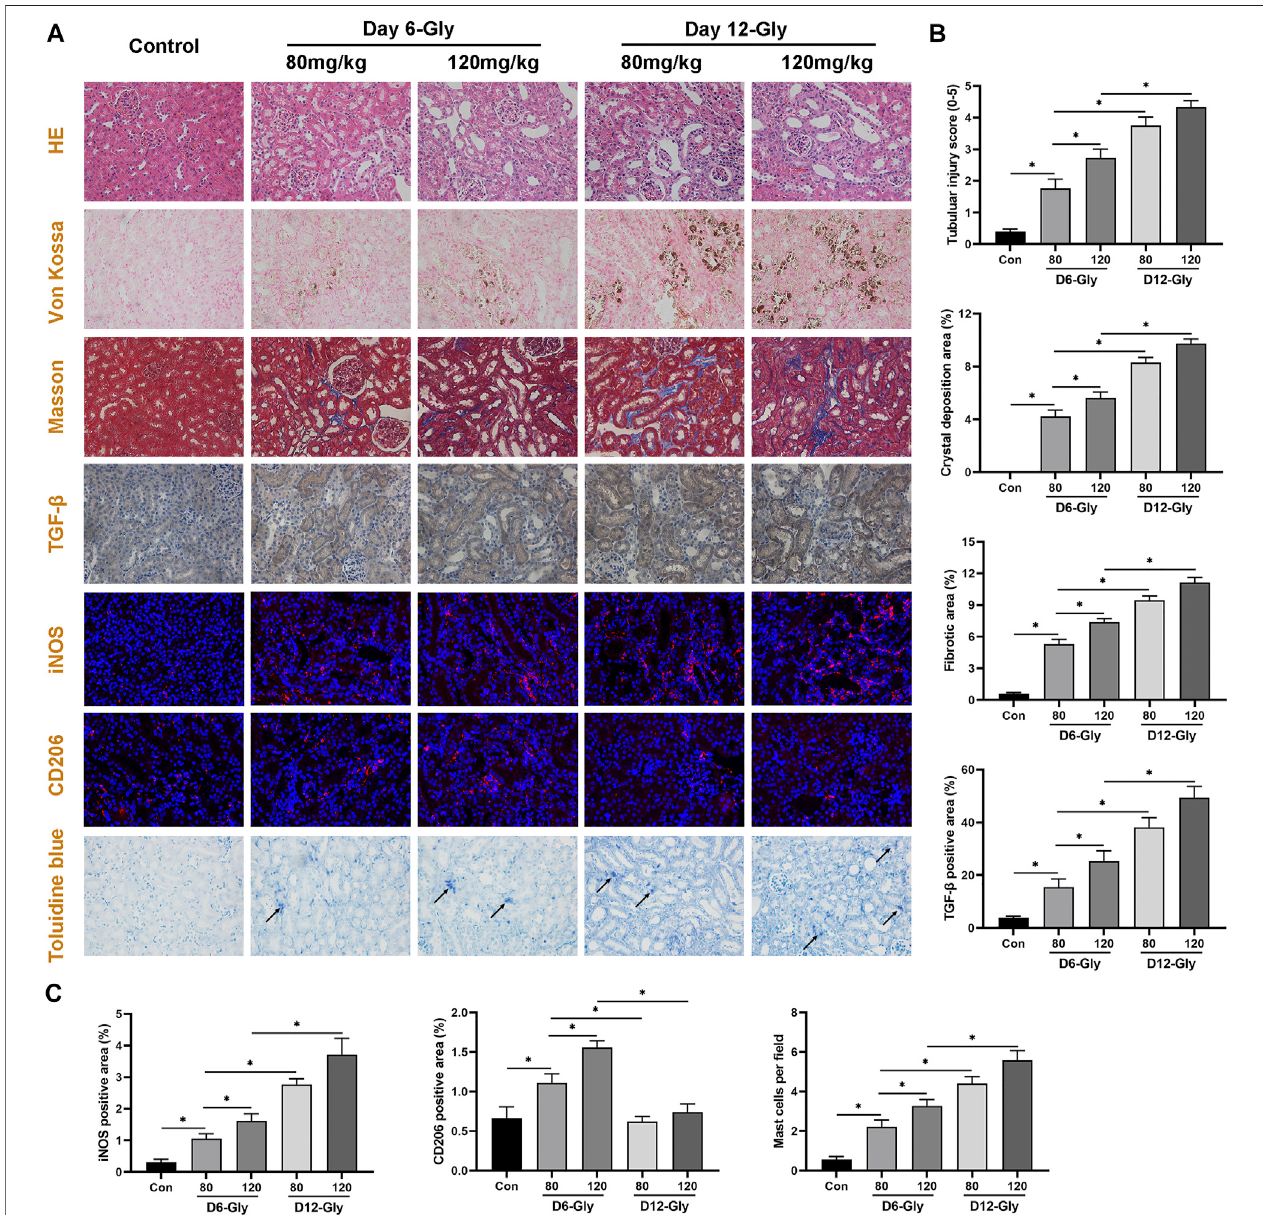
FIGURE 7 | Evaluation of kidney tubular injury, crystal deposition, fi brosis level, macrophage, and mast cell in fi ltration in a glyoxylate-induced hyperoxaluric mouse model. (A) Representative pictures of HE staining, Von Kossal staining, Masson staining, immunohistochemical staining, immuno fl uorescence staining, and Toluidine bluestaining(magni fi cation,400 × ). (B) Quanti fi cationofkidneytubularinjuryscore,CaOxcrystaldepositionarea,collagen fi berdepositionarea,andTGF- β positivearea. (C) Quanti fi cation of macrophage-related molecules in the iNOS (M1) and CD206 (M2) positive areas, and quanti fi cation of activated mast cell per fi eld. Gly, glyoxylate. The arrow indicates activated mast cells. * p <